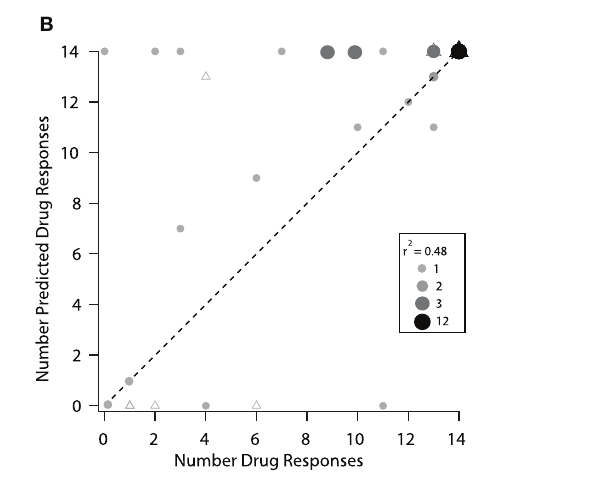
in rate only within the original tuning curve. In some cases, the triagles are covered by the circles. The shade and size of the circle represent the number of neurons overlapping at that point (if a triangle is underneath, it is counted and represented in the size of the circle). The size of the point and the shade of gray indicates the number of neurons that are represented by the particular dot in each of the control and drug plots. The dashed line represents equality in the number of predicted and actual